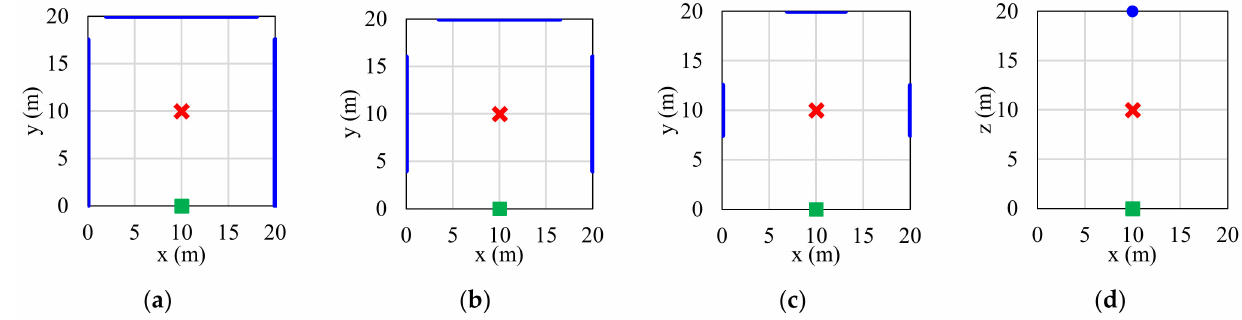
Figure 7. Optimal IRSs pair placement, with fixing first IRS, is marked with green square, in the middle of the wall at position (10, 0, 5), and study position of second IRS. The blue lines mark the possible positions for placing the second IRS to guarantee average total SINR larger than ( a ) 29 dBm, ( b ) 31 dBm, ( c ) 31 dBm, and ( d ) 35 dBm. AP is marked with red cross and its TX gain is 45